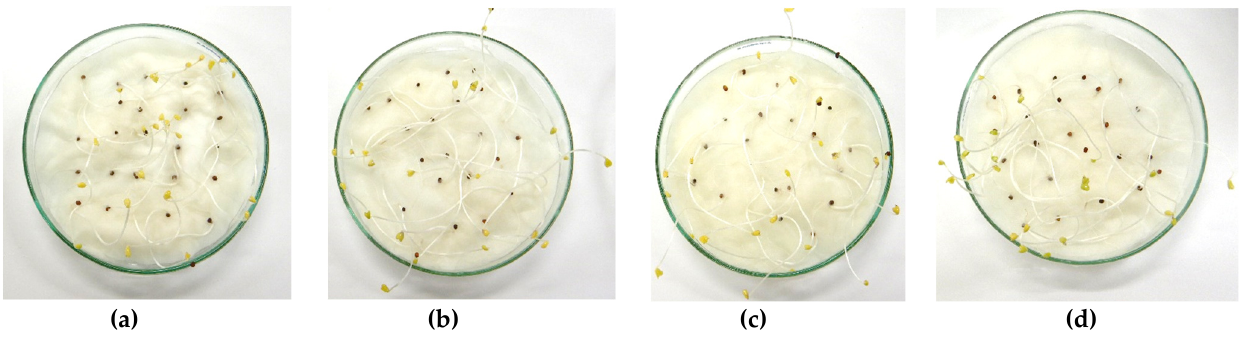
Figure 3. Photographic record of ( a ) control, ( b ) Ulva lactuca , ( c ) Fucus ceranoides , and ( d ) Gracilaria gracilis , after 7 days of incubation. Table 5. Apex length (cm), radicle length (cm), average total length (cm), apex fresh weight (g), fresh radicle weight (g), average weight of seedlings, ± standard error (n = 3), germination percentage (GP) and seedling vigor index (SVI) of kale ( Brassica oleracea L.) within the different treatments, Control (C), U. lactuca (UL), F. ceranoides (FC) and G. gracilis